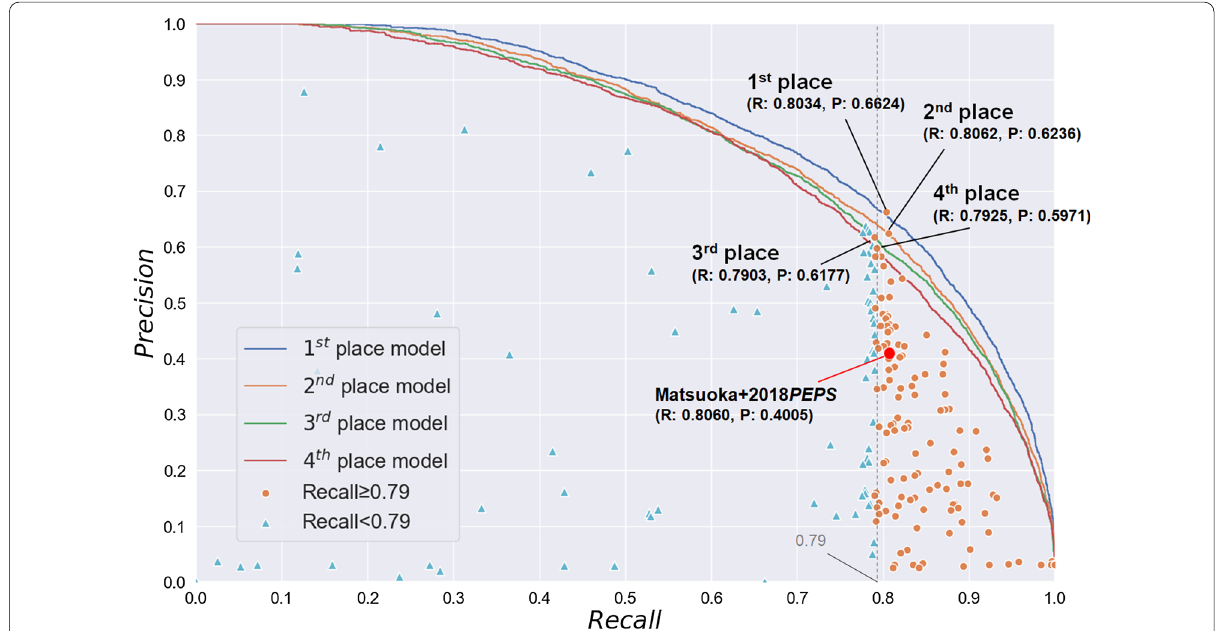
Fig. 6 The final evaluation results of the classification performance of the 209 submissions in the competition